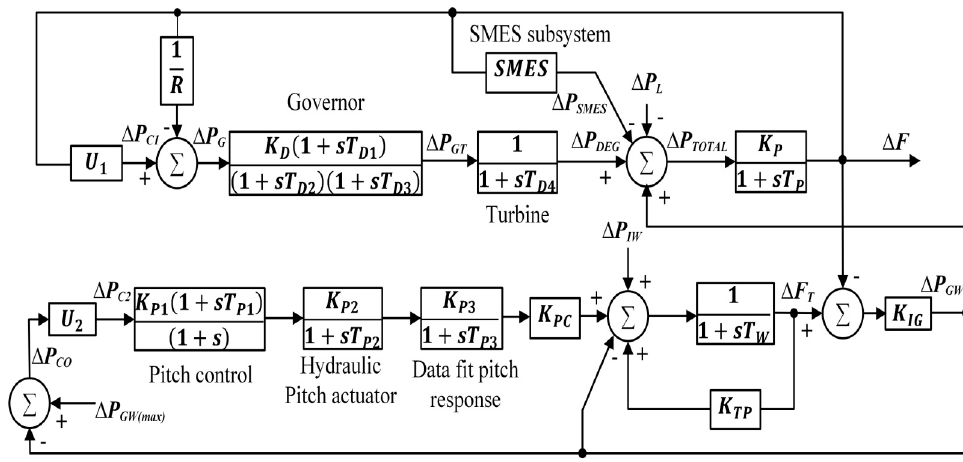
4 of 20 Figure 2. Island hybrid power system model. 3. System Modelling While modelling the system, certain assumptions were made, such as neglecting the nonlinearities and converters in the system while simulating. This was done with the help of a first-order linear transfer function model. Rated capacities selected for work were wind generation of 150 kW, Diesel of 300 kW and an ESD of 28 kW [10]. The whole structural configuration of an island power system is presented in Figure 3. It consists of DEG, WTG and SMES, having individual controllers for both diesel generators and wind turbines. The simulation parameters considered for the whole system are presented in the next section of the manuscript. The total minor power output increment change ( ∆ P Total ) in the island system is given in the following Equation (1): ∆𝑃 (cid:3021)(cid:3042)(cid:3047)(cid:3028)(cid:3039) = ∆𝑃 (cid:3005)(cid:3006)(cid:3008) + ∆𝑃 (cid:3024)(cid:3021)(cid:3008) (cid:3399) ∆𝑃 (cid:3020)(cid:3014)(cid:3006)(cid:3020) − ∆𝑃 (cid:3013)